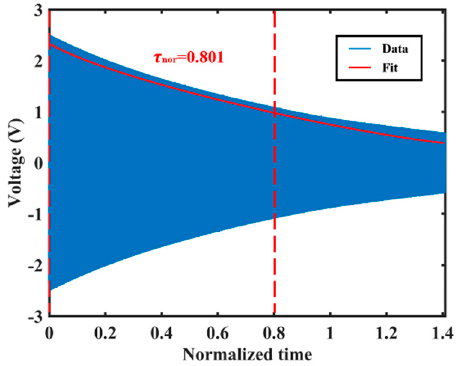
Figure 7. The measured normalized ring-down time constant of the resonator in 253.15 K.